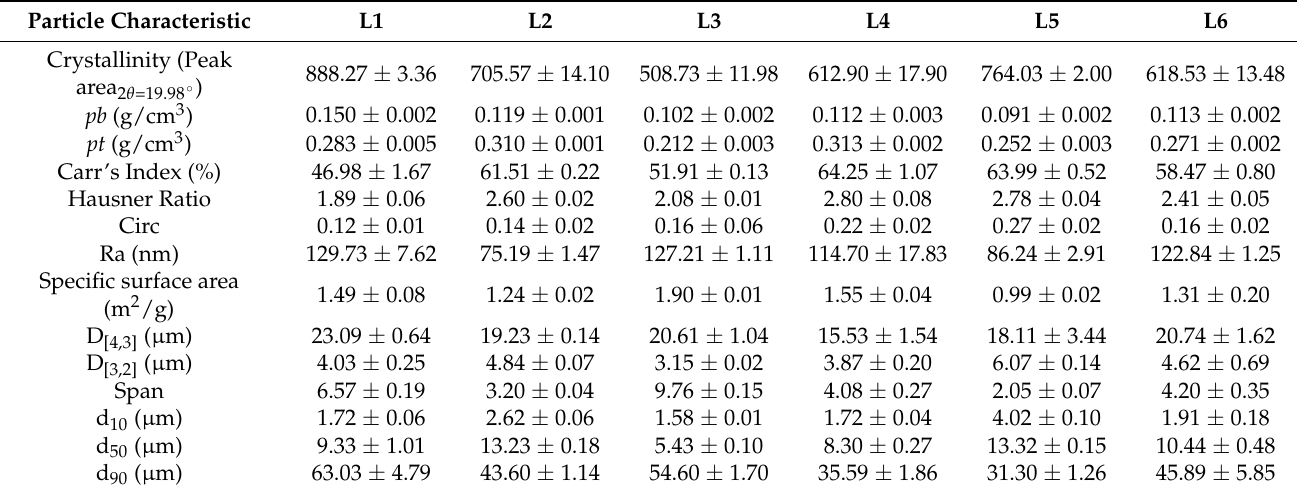
Table 2. Physicochemical attributes of lactose-PEG